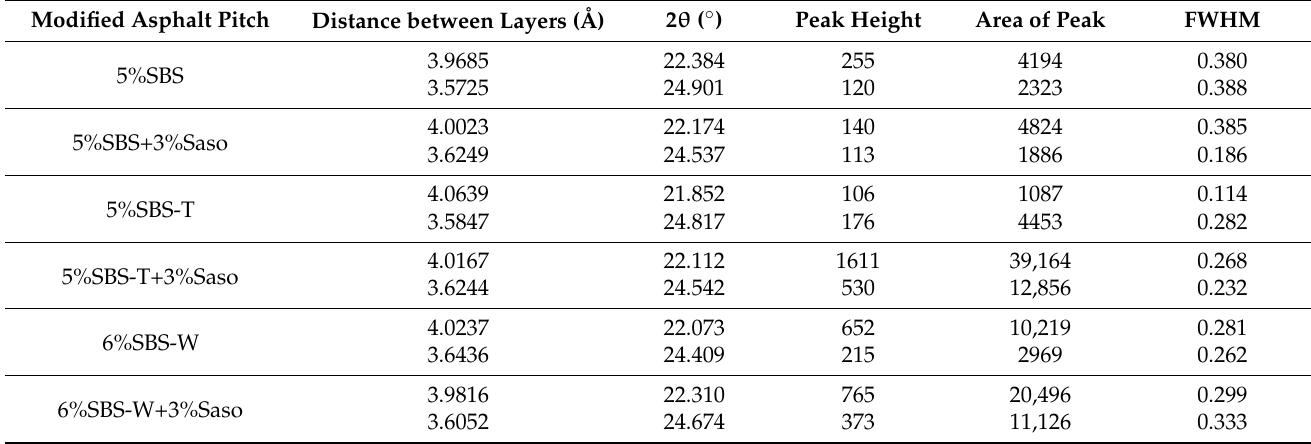
Table 4. XRD peak search report of modified